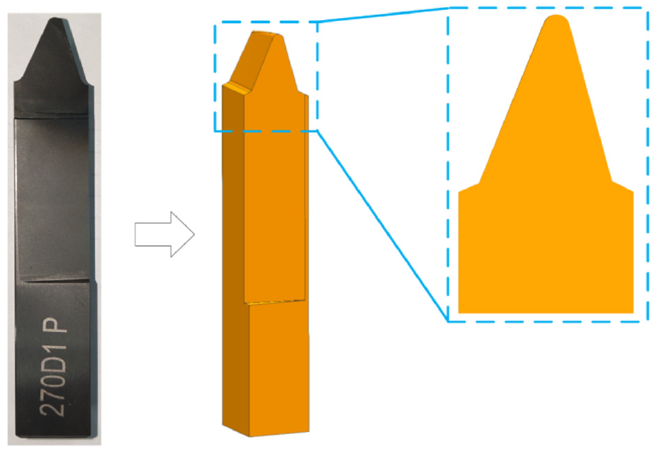
Figure 3. Simplified blade model.